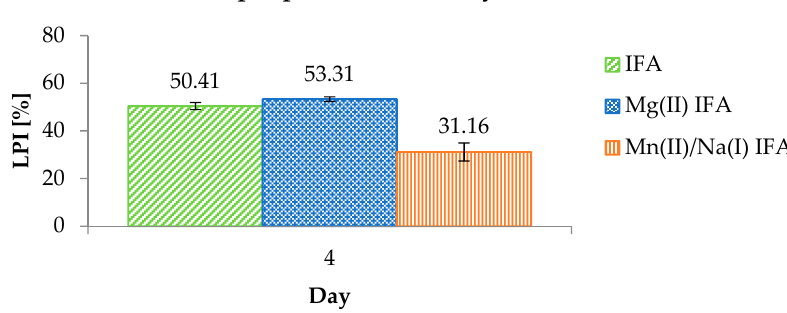
Figure 7. The antioxidant activity of the tested compounds (0.5 mM) measured in the lipid peroxidation assay on the fourth day of measurement.